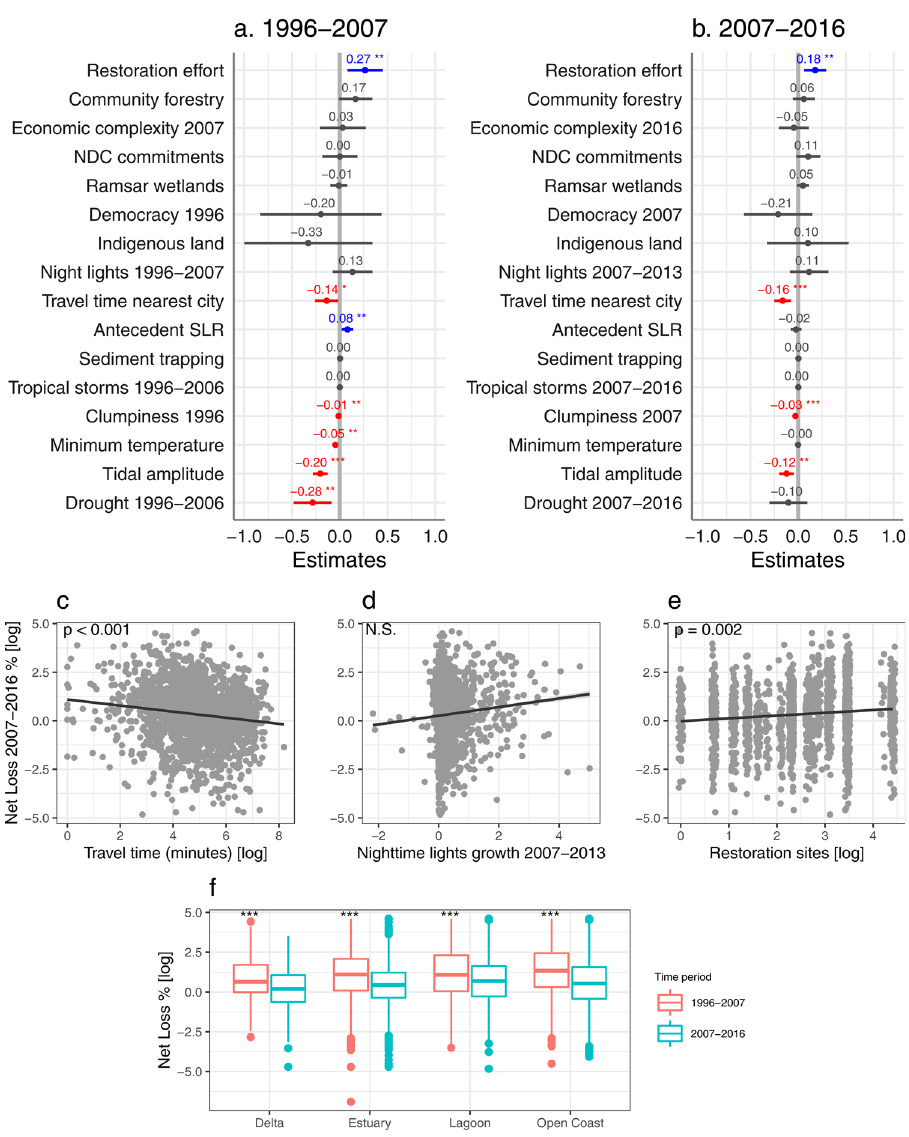
Fig. 3 | Global drivers of mangrove net loss. Fixed effects of socioeconomic and biophysical variables on percent net loss of mangrove cover in 1996 – 2007 ( a ; n = 2004mangrovegeomorphicunitsacross53countries)and2007 – 2016( b ; n =1914 mangrove geomorphic units across 56 countries) showing the estimate and 95% con fi dence intervals from the mixed-effects models. Positive values (in blue) indi- cate that mangrove loss increased with an increase in the variable, while negative values (in red) indicate that mangrove loss decreased with an increase in the vari- able. NDC Nationally Determined Contribution, SLR sea-level rise. Relationship between percent net loss 2007 – 2016 and travel time to nearest city ( c ),night-time